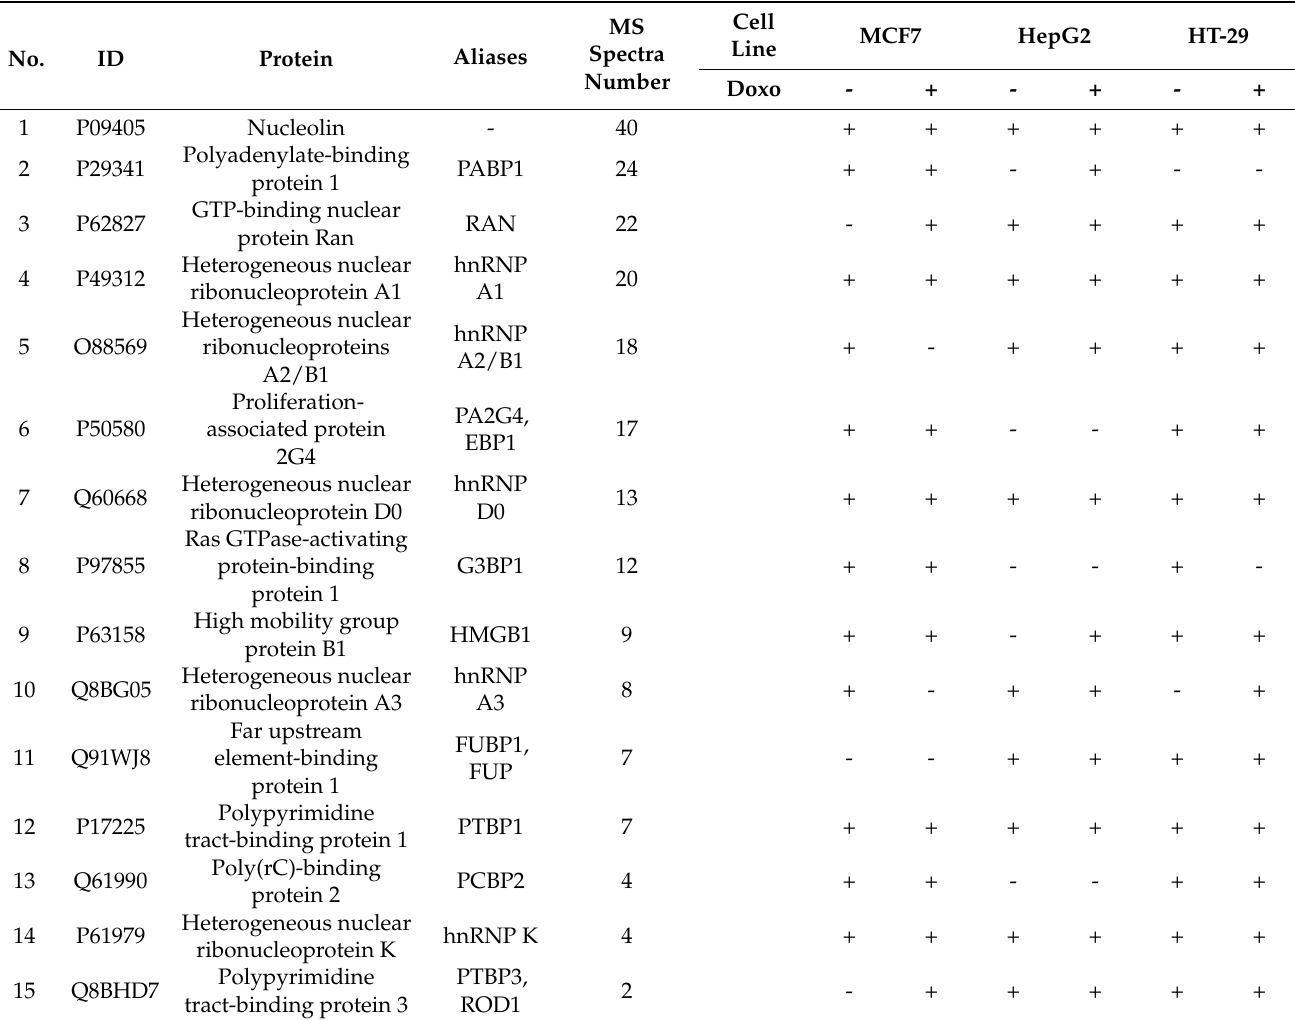
Table 2. List of selected proteins interacting with the 5 (cid:48) -terminus of p53 mRNA (this work) compared to proteins present in human cell lines MCF7, HepG2 and HT-29, as identified in